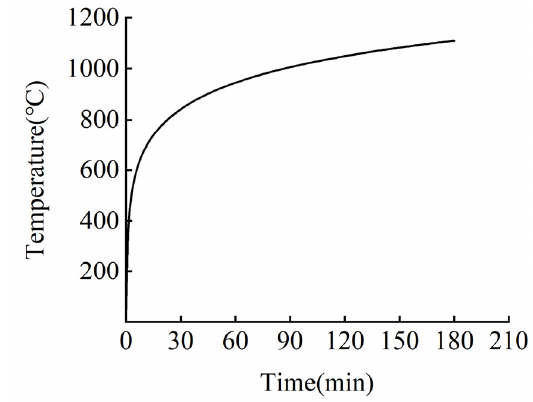
Figure 17. Temperature rise curve of ISO-834.